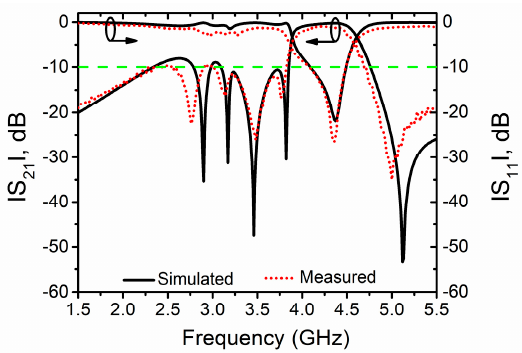
Figure 12. Filter responses of Case G ( C F = 1.5 pF, C S = 100 pF, C T = 1.4 pF).